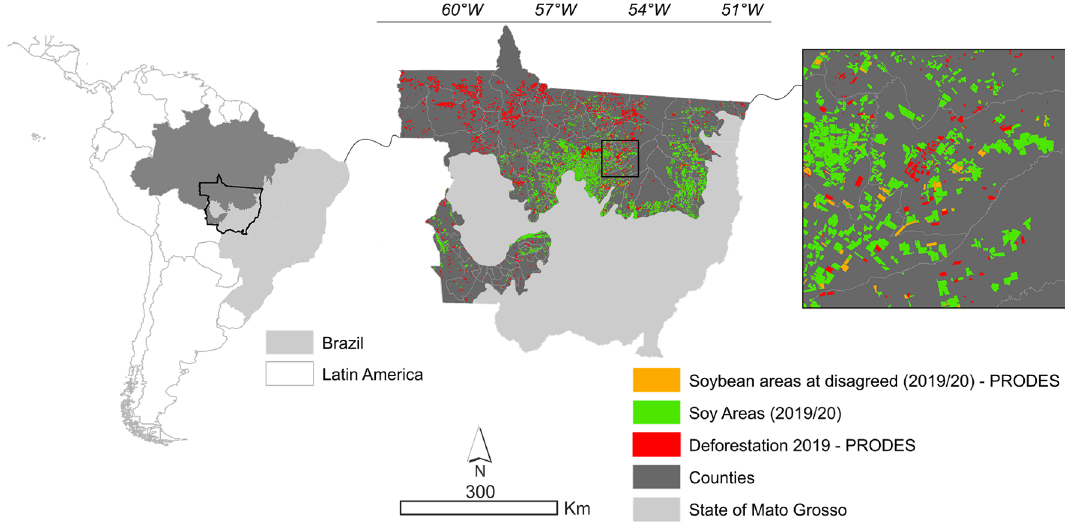
Figure 14. Study area comprising the Mato Grosso Amazonia